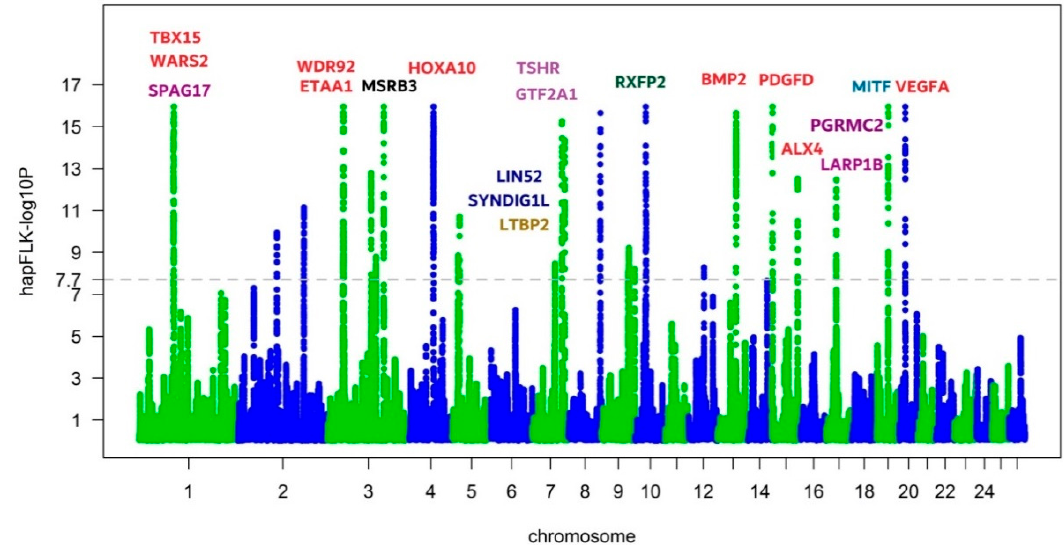
Figure 4. Manhattan plot of hapFLK values on the sheep autosome. The gray horizontal line denotes 0.01 genome-wide threshold ( − log10(0.01 / 500,593) = 7.77).